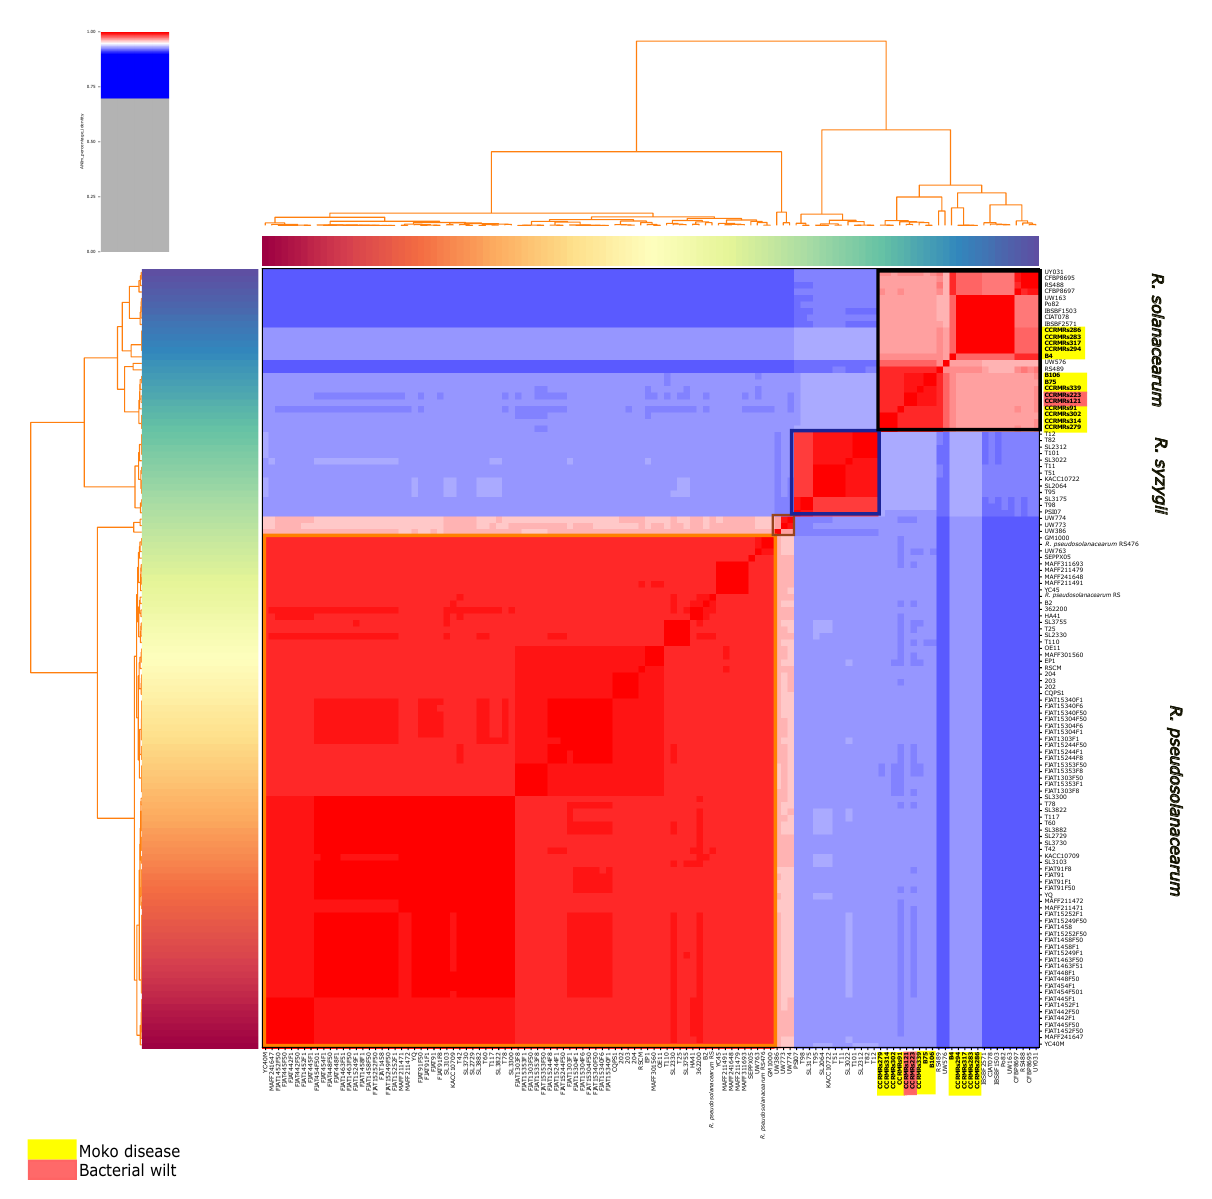
Figure 6. ANI analysis clustermap of public R. solanacearum genomes on NCBI and 14 new Brazilian R. solanacearum genomes. Upwards, there are phylotypes I (orange box), III (brown box), IV (blue box), IIA, and IIB clusters (black box), composing R. pseudosolanacearum , R. syzygii , and R. solanacearum , respectively. Newly sequenced genomes are in bold and highlighted in red and yellow according to their respective